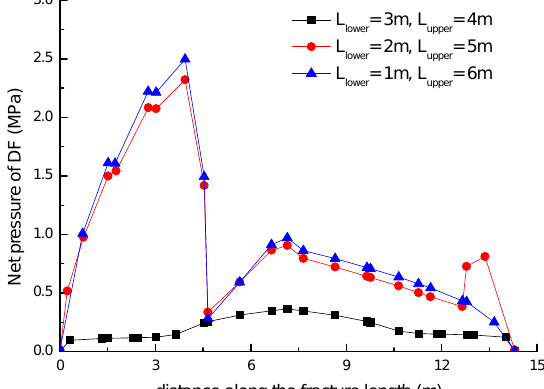
Figure 8. The net pressure curves of the DF along the fracture length at different lengths of the lower and upper parts of the NF. The distance in the x -axis is along the direction from the lower parts to the upper parts of the